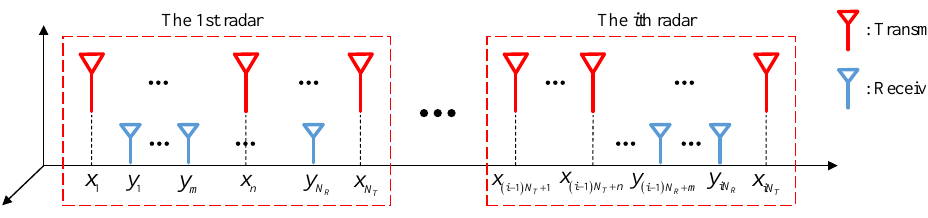
Figure 2. Symbolic representation in one of the subarrays.